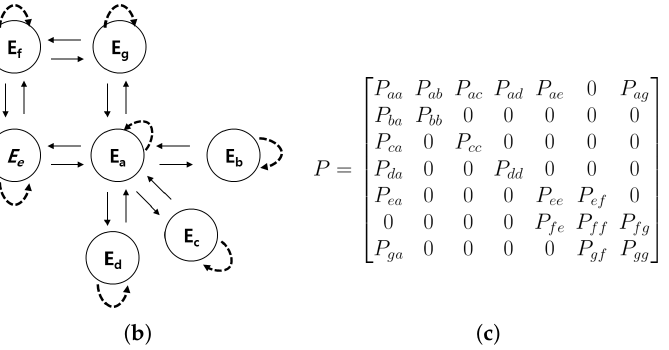
Figure 6. ( a ) Mission environment, ( b ) state transition diagram, and ( c ) state transition matrix for AMR.